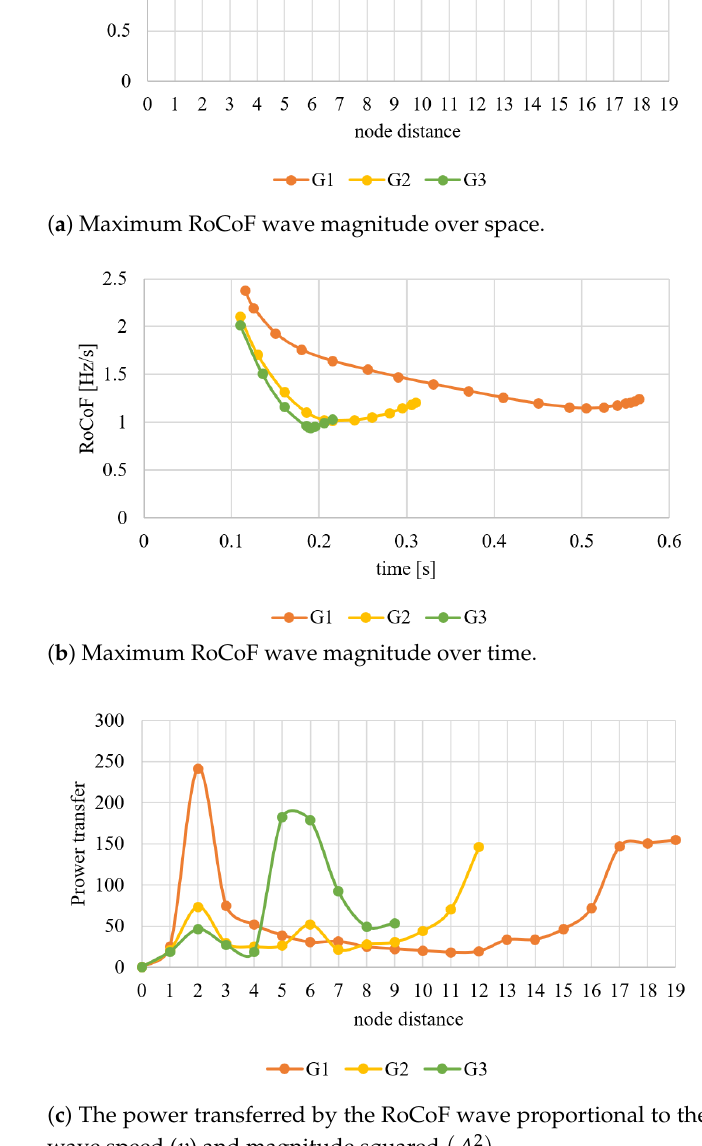
Figure 8. Disturbance wave parameter plots. ( a ) RoCoF magnitude versus space (position), ( b ) RoCoF magnitude versus time, and ( c ) Rate of energy (power) transfer of the